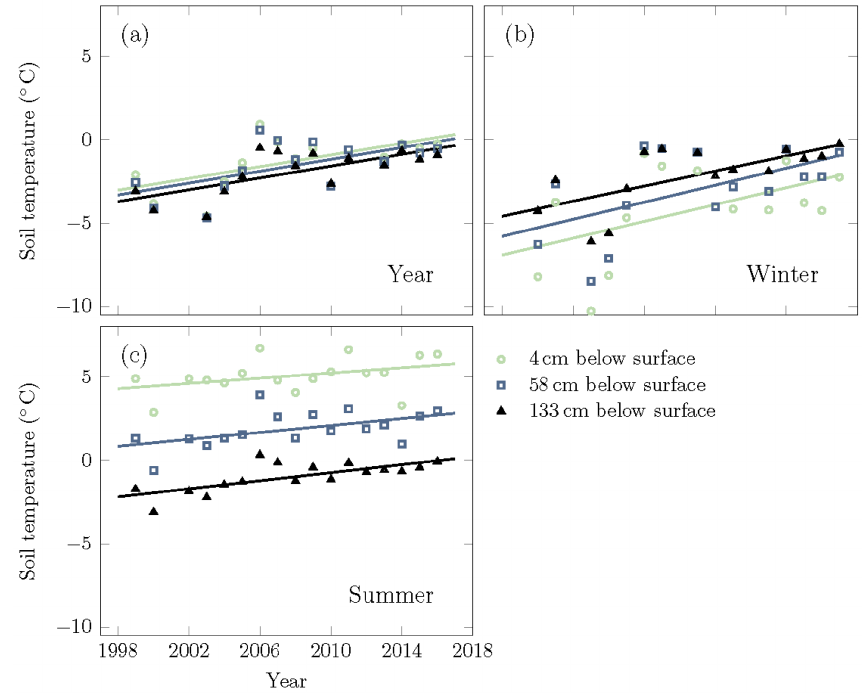
Figure 4. Bayelva mean 20-year temperature increases for three depths from September 1998 to September 2017 using level 2 soil tem- peratures. (a) In the active layer (4 and 58cm) and in the top of permafrost (138cm): 0.18 ± 0.07 ◦ Cyear − 1 ; (b) in winter (December, January, February): 0.25 ± 0.12, 0.25 ± 0.11 and 0.23 ± 0.07 ◦ Cyear − 1 , respectively; and (c) in summer (June, July, August): 0.08 ± 0.05, 0.10 ± 0.04 and 0.12 ± 0.03 ◦ Cyear − 1 , respectively. Years in which data gaps of more than 48h exceeded 5% of data were included; data gaps were interpolated